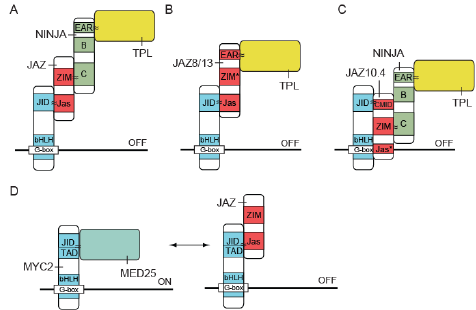
Figure 3. JAZ proteins repress JA signaling. ( A ) JAZ proteins interact with bHLH-type TFs, such as MYC2/3/4, mediated by direct binding between the Jas and JAZ-interacting domain (JID) domains, respectively. The ZIM domain of most JAZ proteins can interact with the adapter protein